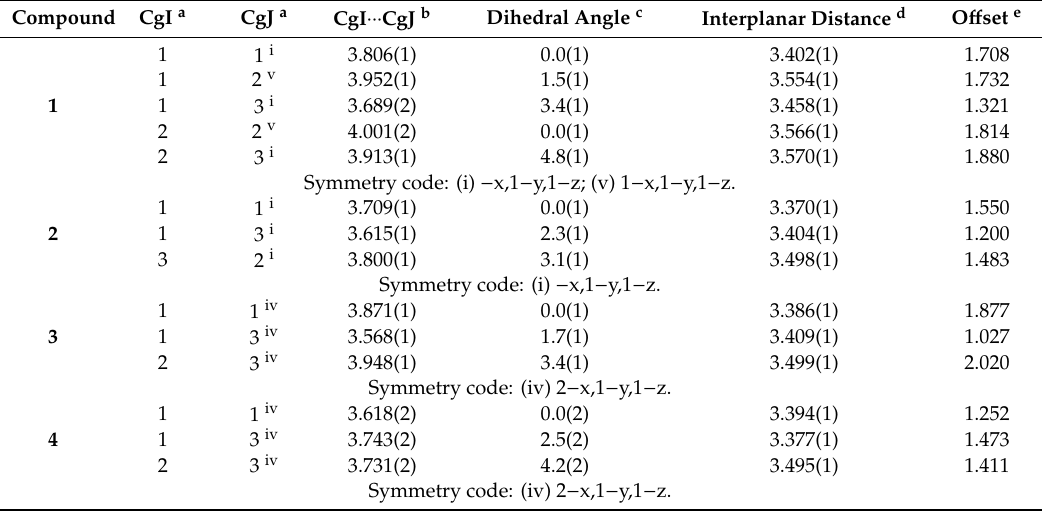
Table 3. π – π interactions for compounds 1–4 (distance in Å and angles in